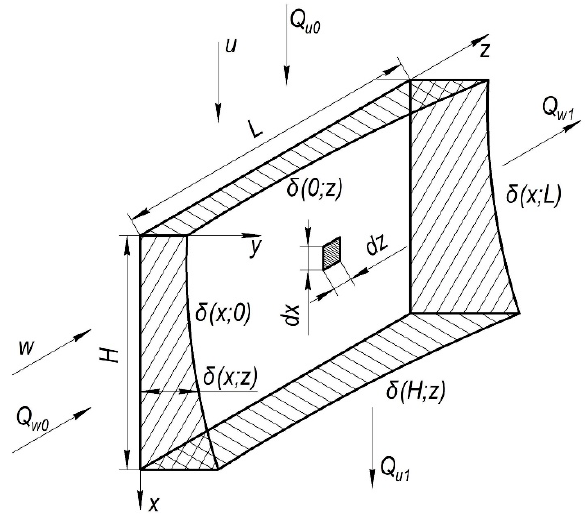
Figure 1. The design scheme of the liquid downflow.